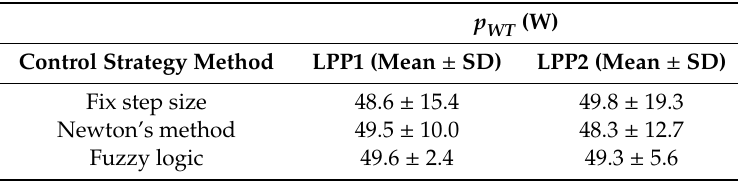
Figure 16. Statistical analysis of experimental results: ( a ) evolution of p WT at LPP1; ( b ) evolution of p WT at LPP2. Table 2. p WT reached using different control method strategies. SD: standard deviation.